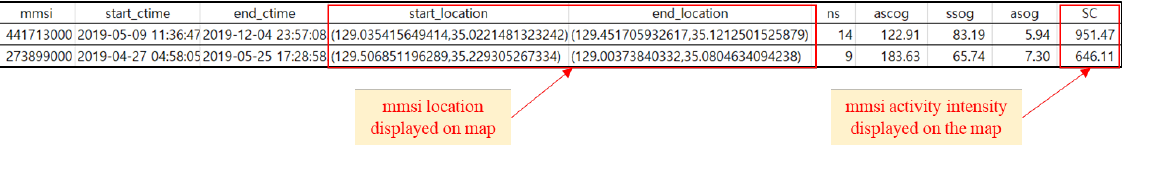
Figure 10. Preprocessing results of AIS data for fishing ships.